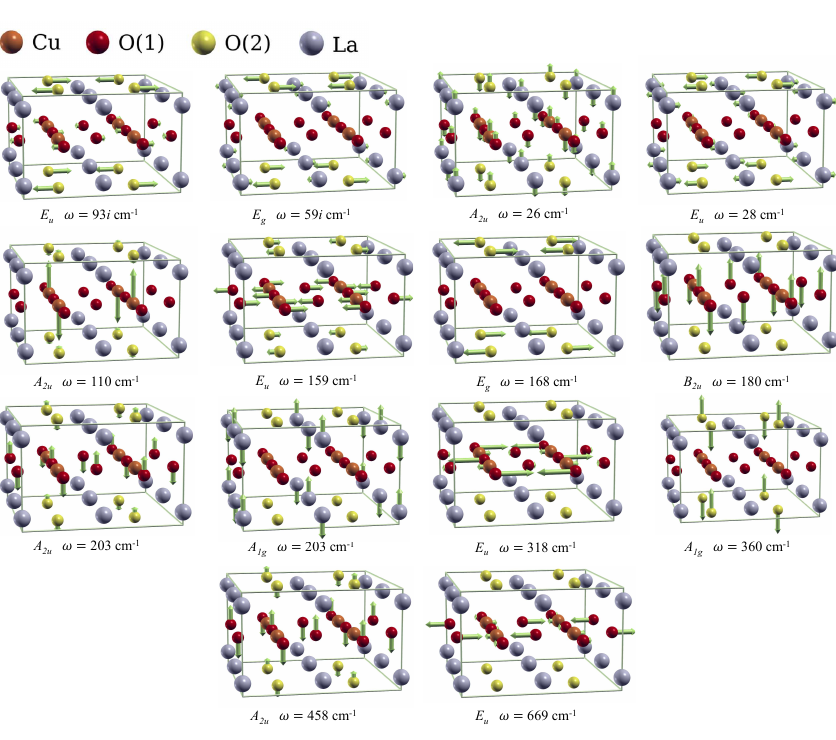
Figure A3: All LCO modes at the M point, represented in a 2x2 supercell. Table A2: Bi2201 mode frequencies and assignments at Γ , X and M . All mode frequencies are in cm − 1